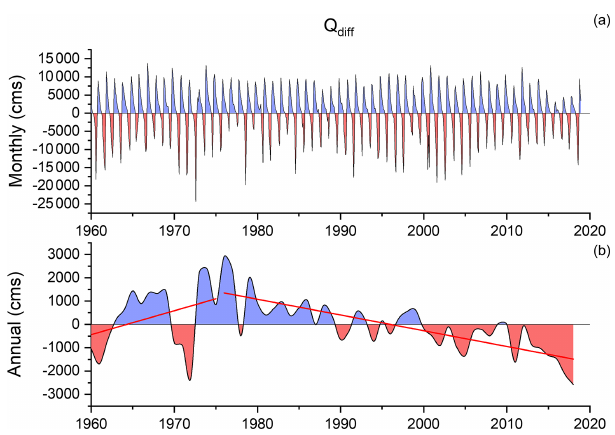
Figure 8. (a) Time series plot of Q diff from 1960 to 2019 with monthly steps. (b) Time series plot of Q diff from 1960 to 2019 with yearly steps. From 1976–2019, Q diff decreased at a slope of − (68 ± 8)m 3 s − 1 yr − 1 ( p< 0 .